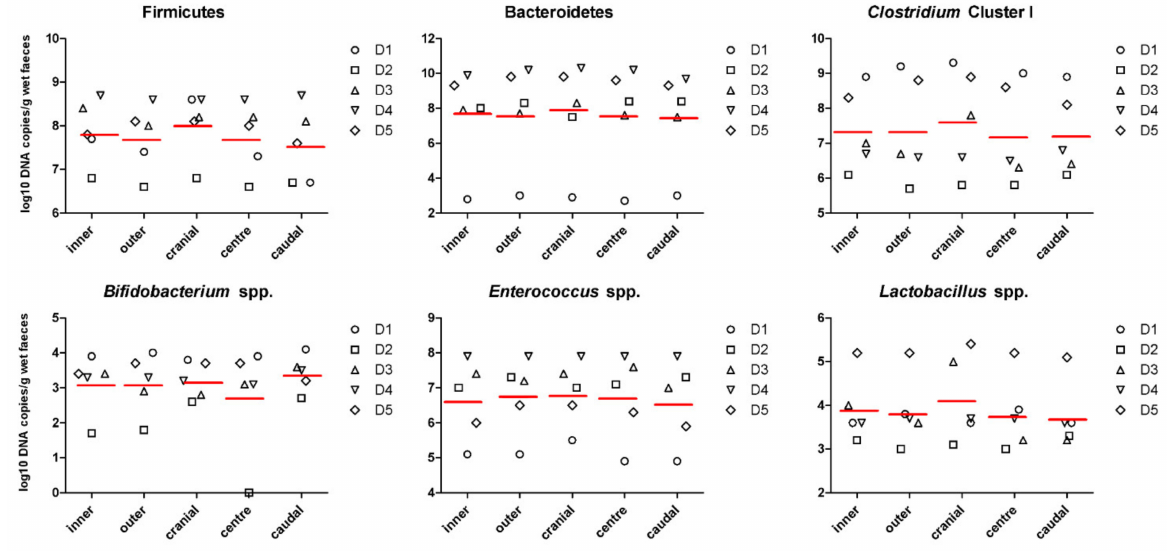
Figure 2. The abundances of selected bacterial taxa in stool subsamples collected from five different dogs. Values are expressed as log10 DNA copies per gram of wet faeces. Red lines represent the mean of log10 DNA. Dn = dog